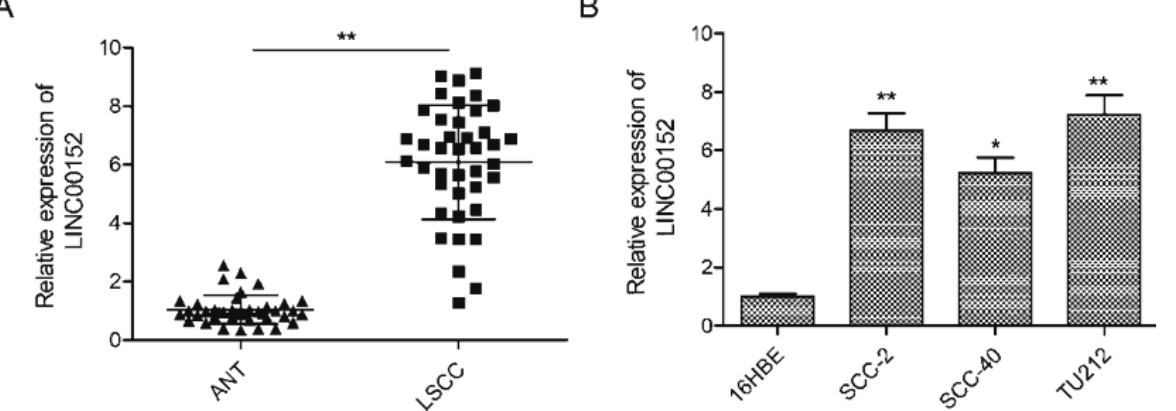
Figure 1: LINC00152 was significantly upregulated in LSCC tissue and cell lines. (A) The expression of LINC00152 was increased in LSCC tissue compared to adjacent normal tissue (ANT). (B) The expression of LINC00152 was increased in three LSCC cell lines (SCC-2, SCC-40 and TU212) compared to normal bronchial epithelial cell line ( 16HBE). **P <